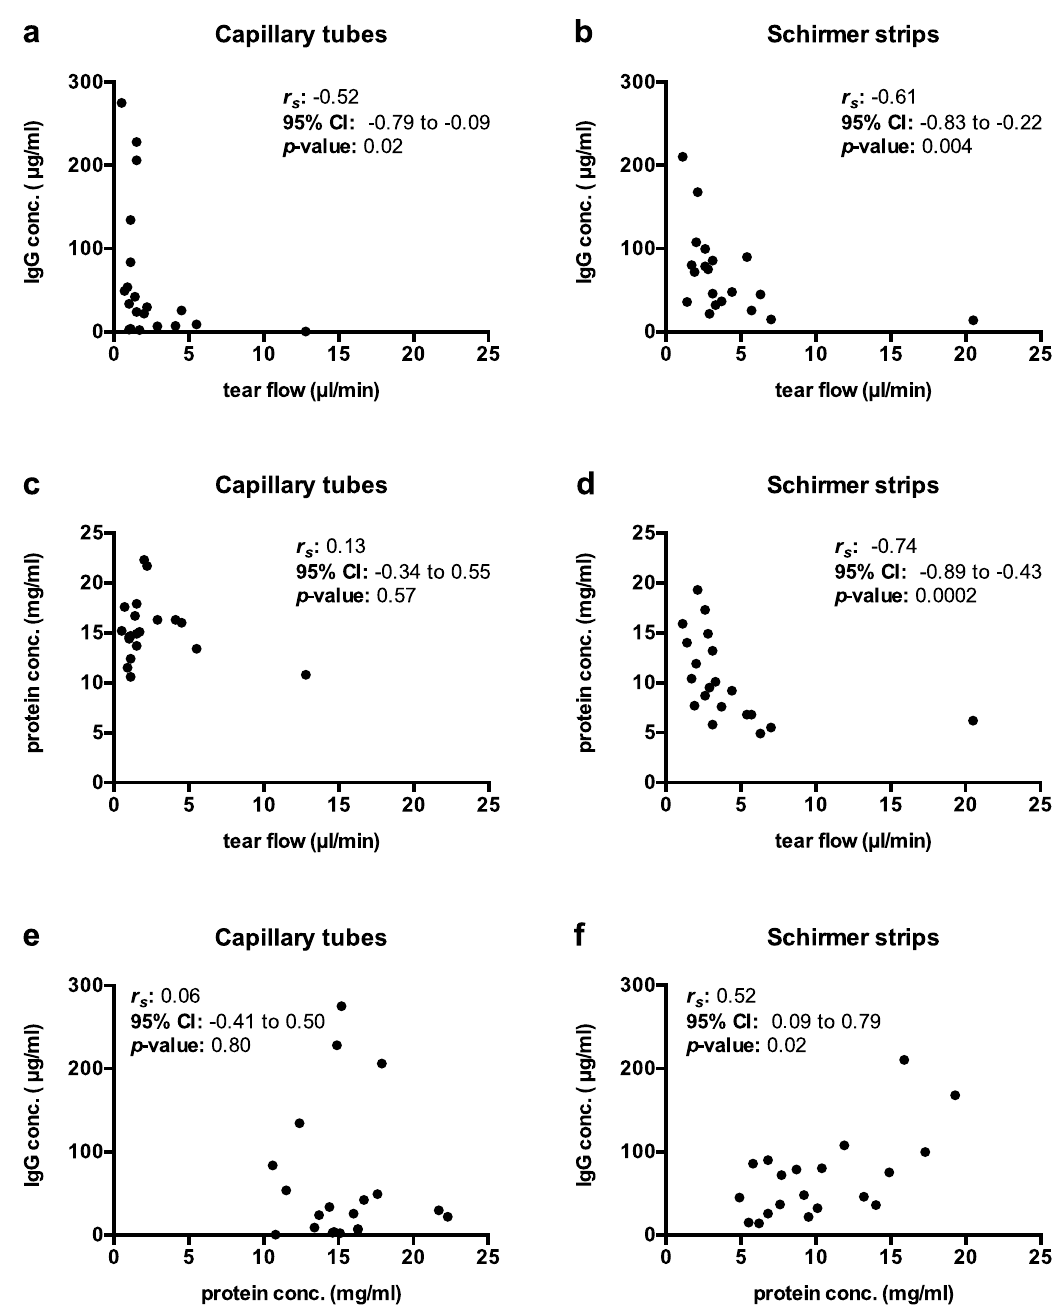
Figure 3. Correlation analysis for tear flow rate, IgG, and protein concentration. Spearman rank correlation was performed to investigate a potential correlation between tear flow rate, IgG concentration, and protein concentration for samples collected with capillary tubes and Schirmer strips. A moderate correlation was observed between tear flow rate and IgG concentration for capillary tubes ( a ) and Schirmer strips ( b ). A strong correlation was observed between tear flow rate and protein concentration for Schirmer strips ( d ) while no correlation was observed for capillary tubes ( c ). Between IgG and protein concentration no association was observed for capillary tubes ( e ) and a moderate association for Schirmer strips ( f ). n = 20, significant for p < 0.05. r S : Spearman’s rank coefficient; CI: confidence interval; conc.: